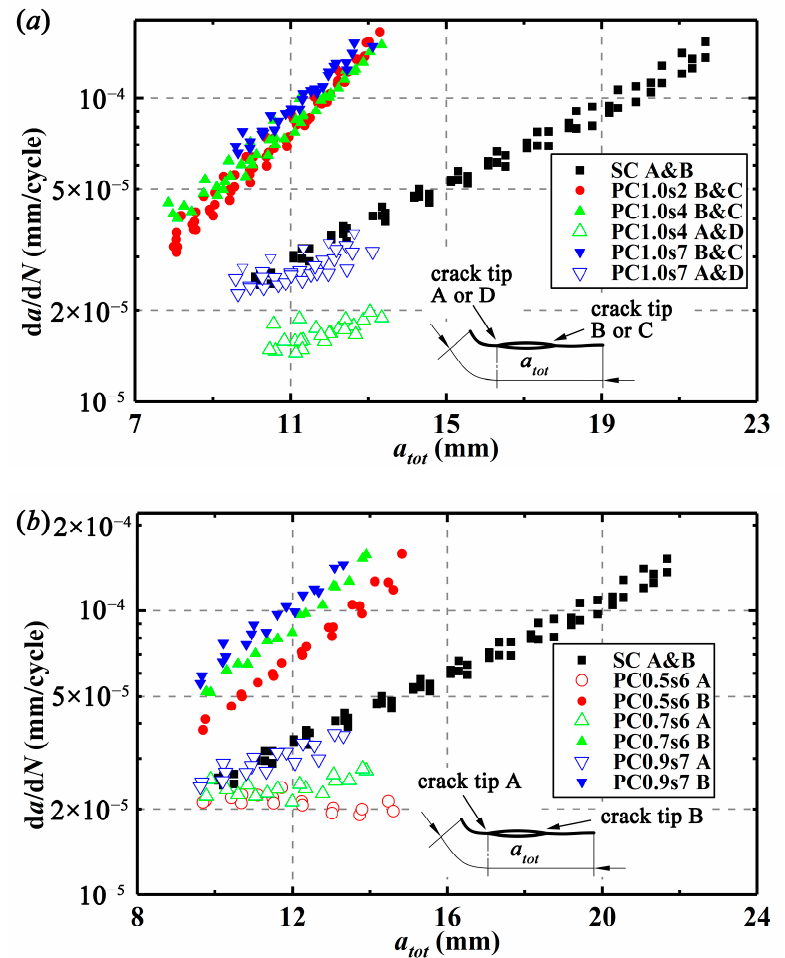
Figure 4. Crack growth rates vs total crack growth length: ( a ) for double equal cracks and single crack and ( b ) for double unequal cracks and single crack.